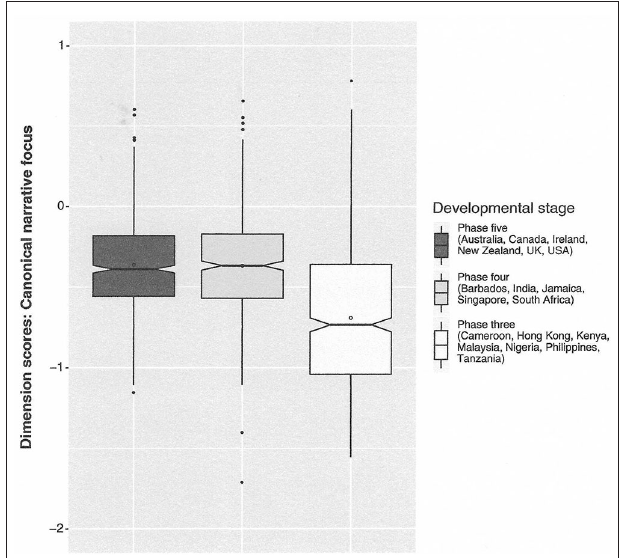
FIGURE 23 | Bohmann’s “Distributions of dimension scores for countries in different phases according to the Dynamic Model: ICE data only: CANONICAL NARRATIVE FOCUS” (from Bohmann, 2020, p. 131).